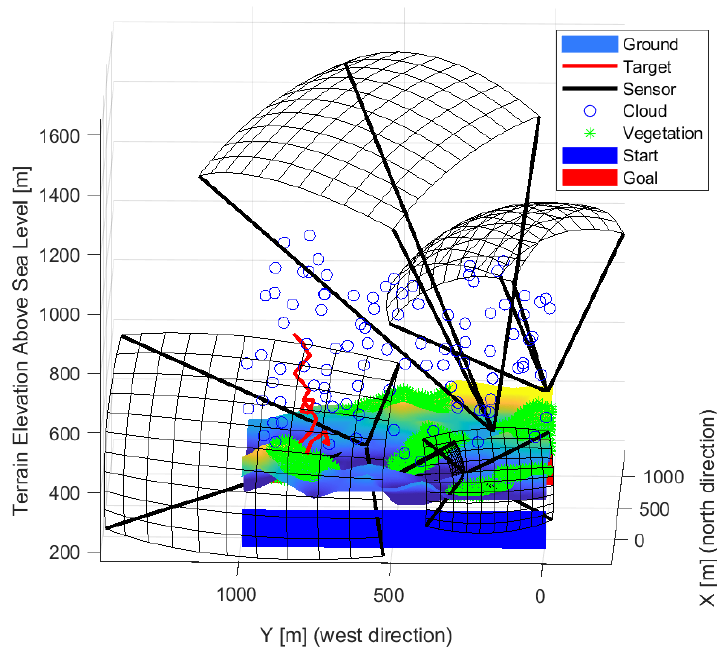
Figure 15. The solution in the case of the five sensors